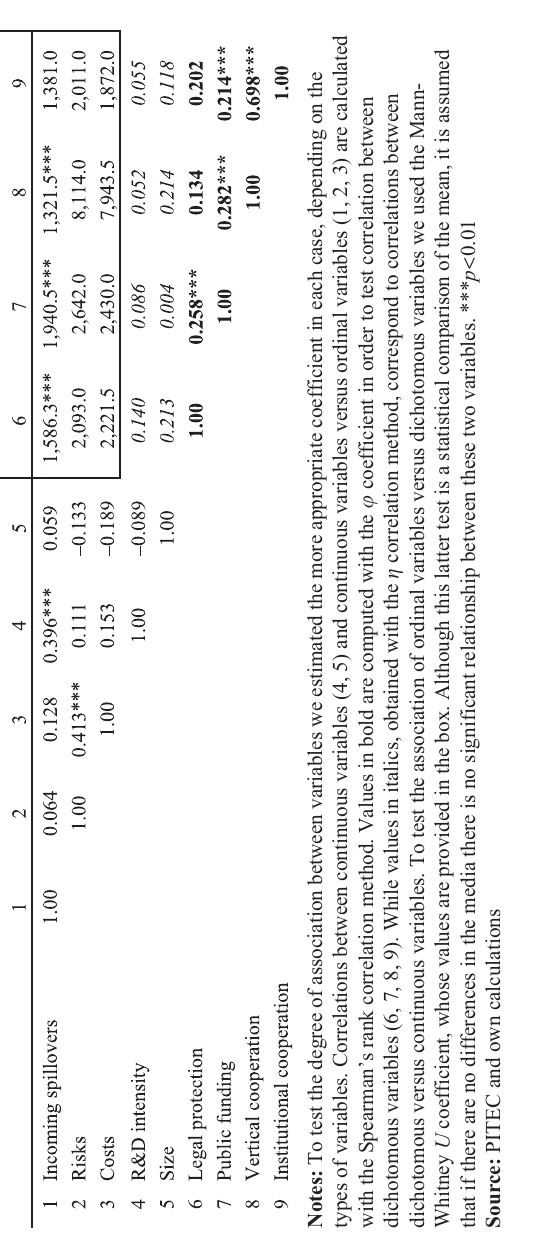
Table AI. Association between variables used in the regression